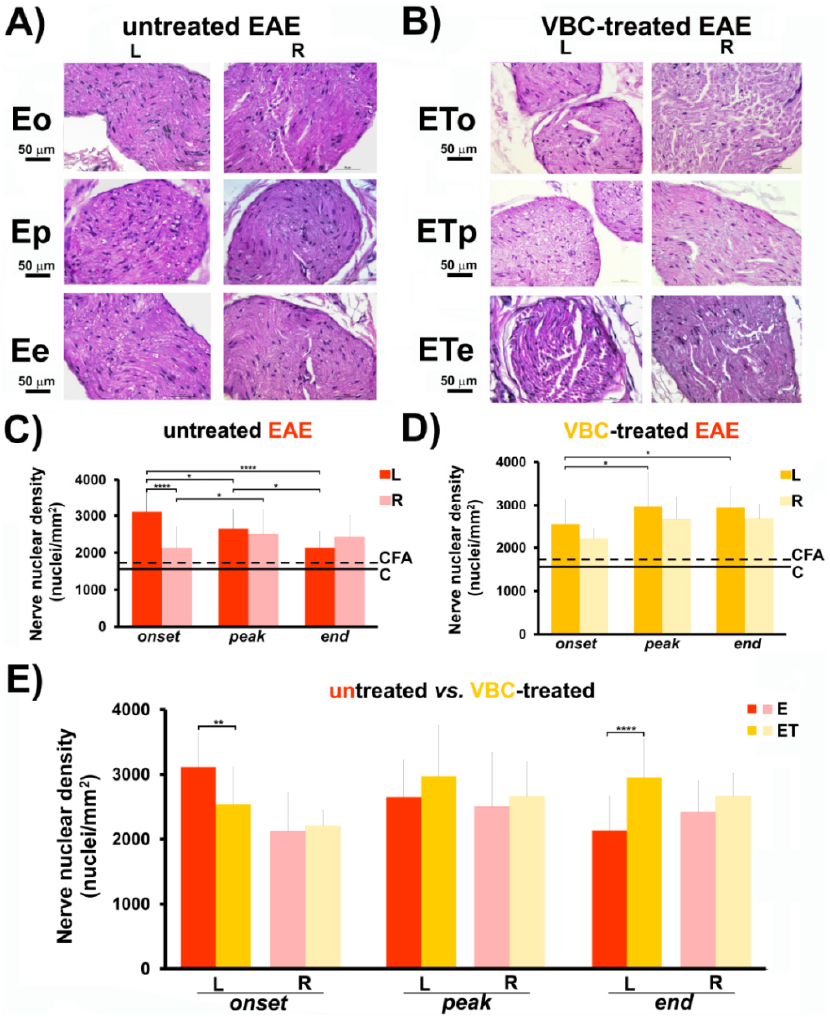
Figure 4. The effects of VBC treatment on nerve nuclear density during EAE. ( A ) Histological changes of nerve nuclear density in untreated EAE rats ( E ). Scale bar 50 µ m (Magnification 40 × ). ( B ) Histological changes of nerve nuclear density in VBC-treated EAE rats ( ET ). Scale bar 50 µ m (Magnification 40 × ). ( C ) Changes in nerve nuclear density in untreated EAE rats ( E ). ( D ) Changes in nerve nuclear density in VBC-treated EAE rats ( ET ). ( E ) Changes in nerve nuclear density compared in both groups ( E and ET ). The nuclear density is monitored in three different time points: onset ( o ), peak ( p ), and end ( e ) of the disease. Control intact rats ( C ), rats s.c. injected only with Complete Freund’s adjuvant ( CFA ). Left ( L ) and right ( R ) nerve. Results are presented as the mean ± standard error (SE). **** p < 0.0001; ** p < 0.01; * p < 0.05.